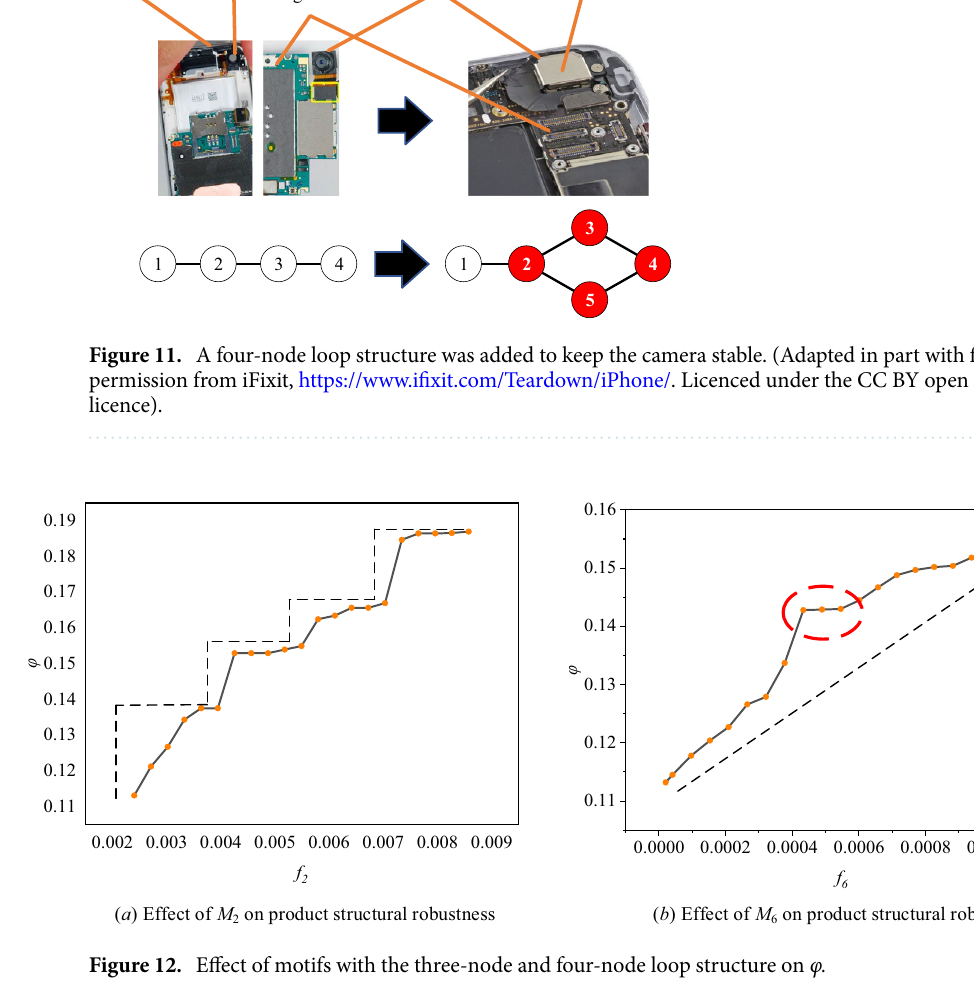
Figure 12. Effect of motifs with the three-node and four-node loop structure on